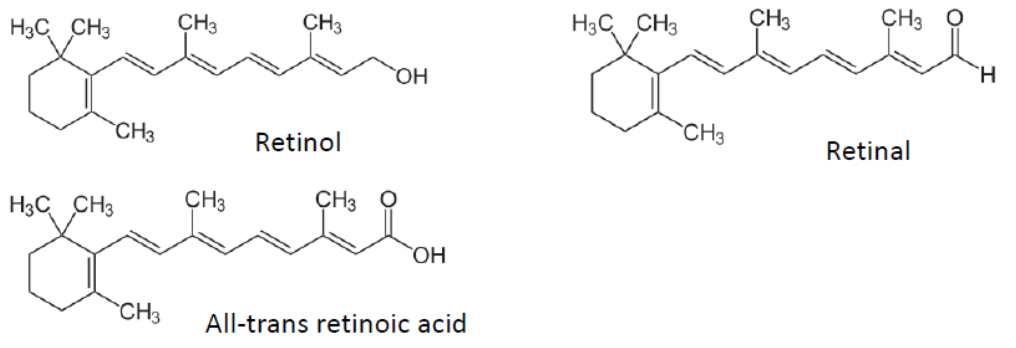
Figure 1. Vitamin A and metabolite